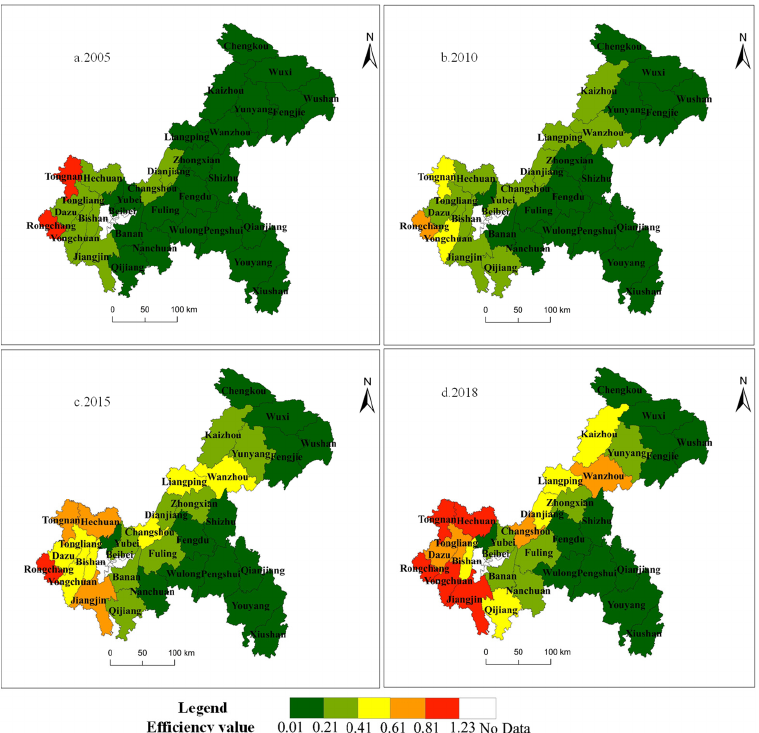
Figure 3. Spatial distribution pattern of the RNCUE in Chongqing from 2005 to 2018. ( a ) 2005; ( b ) 2010; ( c ) 2015; ( d ) 2018.